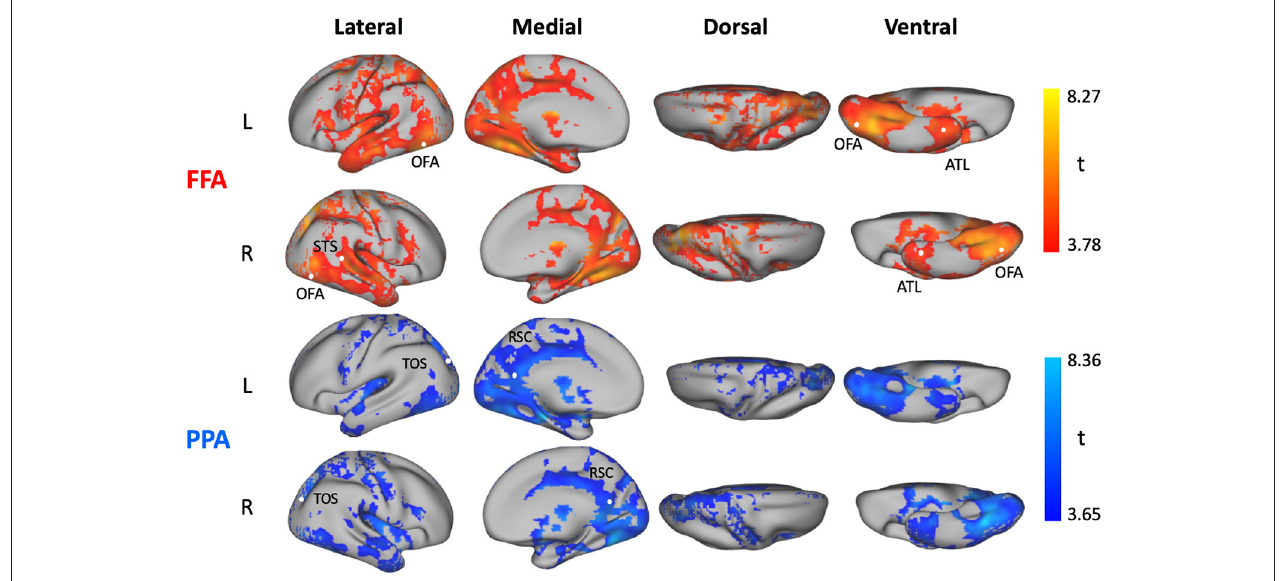
FIGURE 3 | Comparison between neural network (NN) models and linear regression (LR) models. Statistical t-maps computed across subjects from the voxelwise difference between the average variance explained predicted by three NN models ( NN_1layer, NN_5layer, NN_5layer_dense ), and the average variance explained